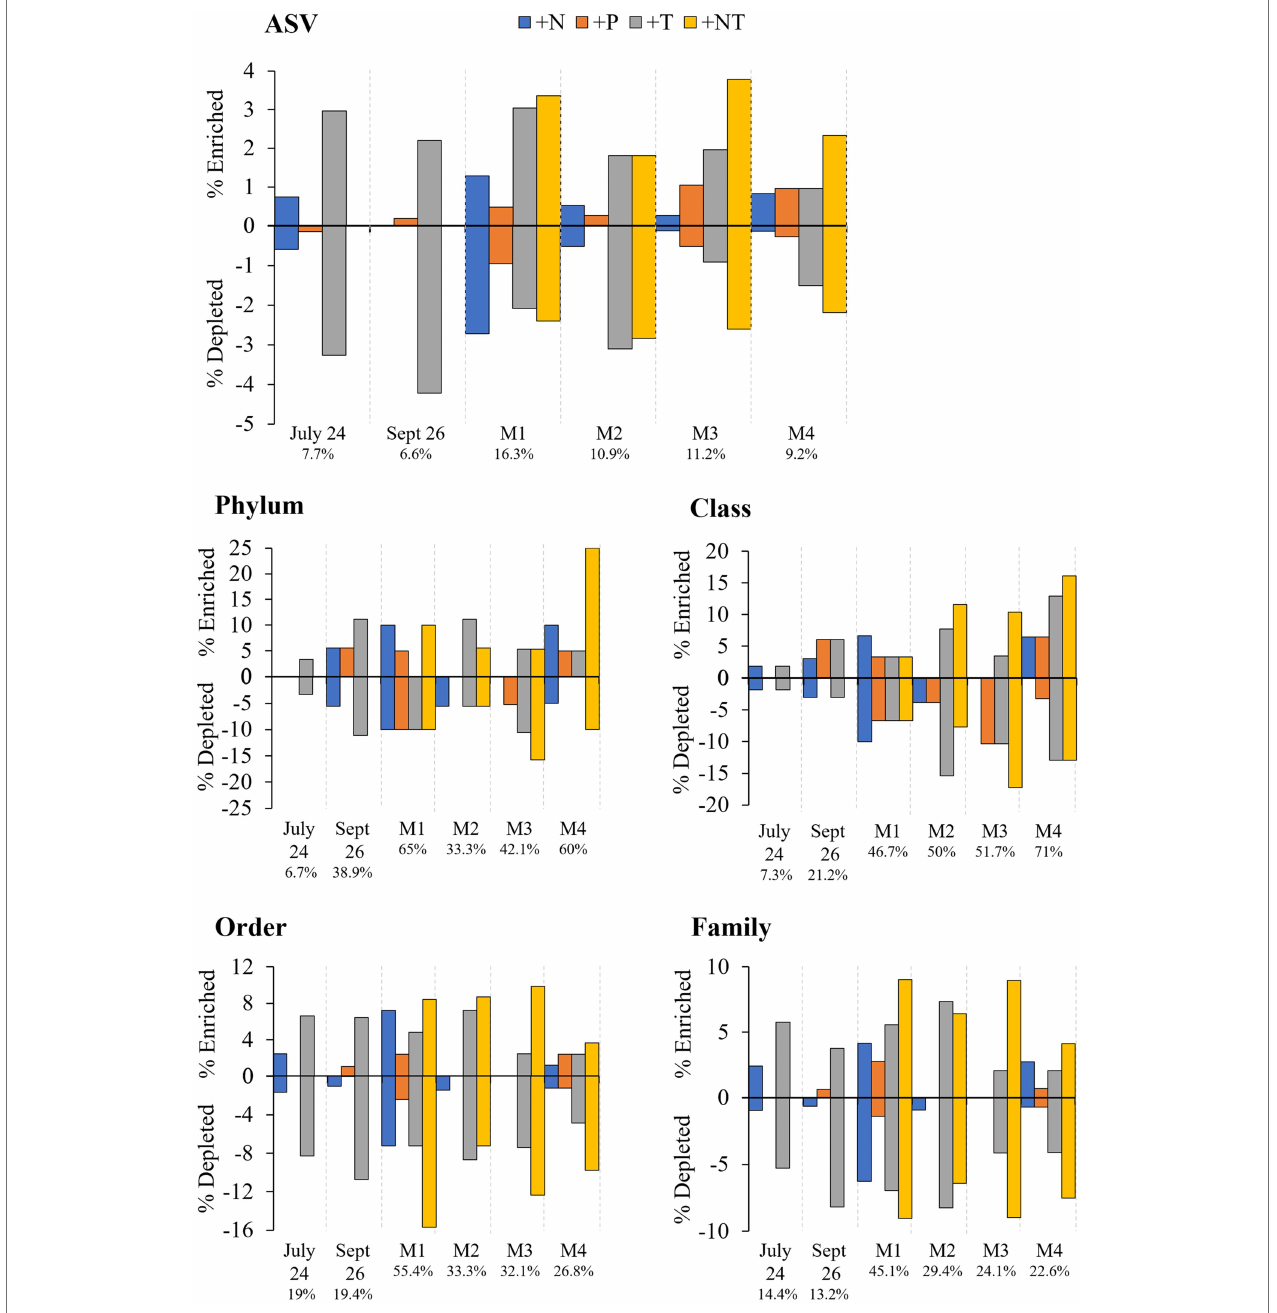
FIGURE 6 | Percent enrichment and depletion of amplicon sequence variants (ASVs) per treatment. Number under experiment label indicates total percent ASVs altered across treatments per